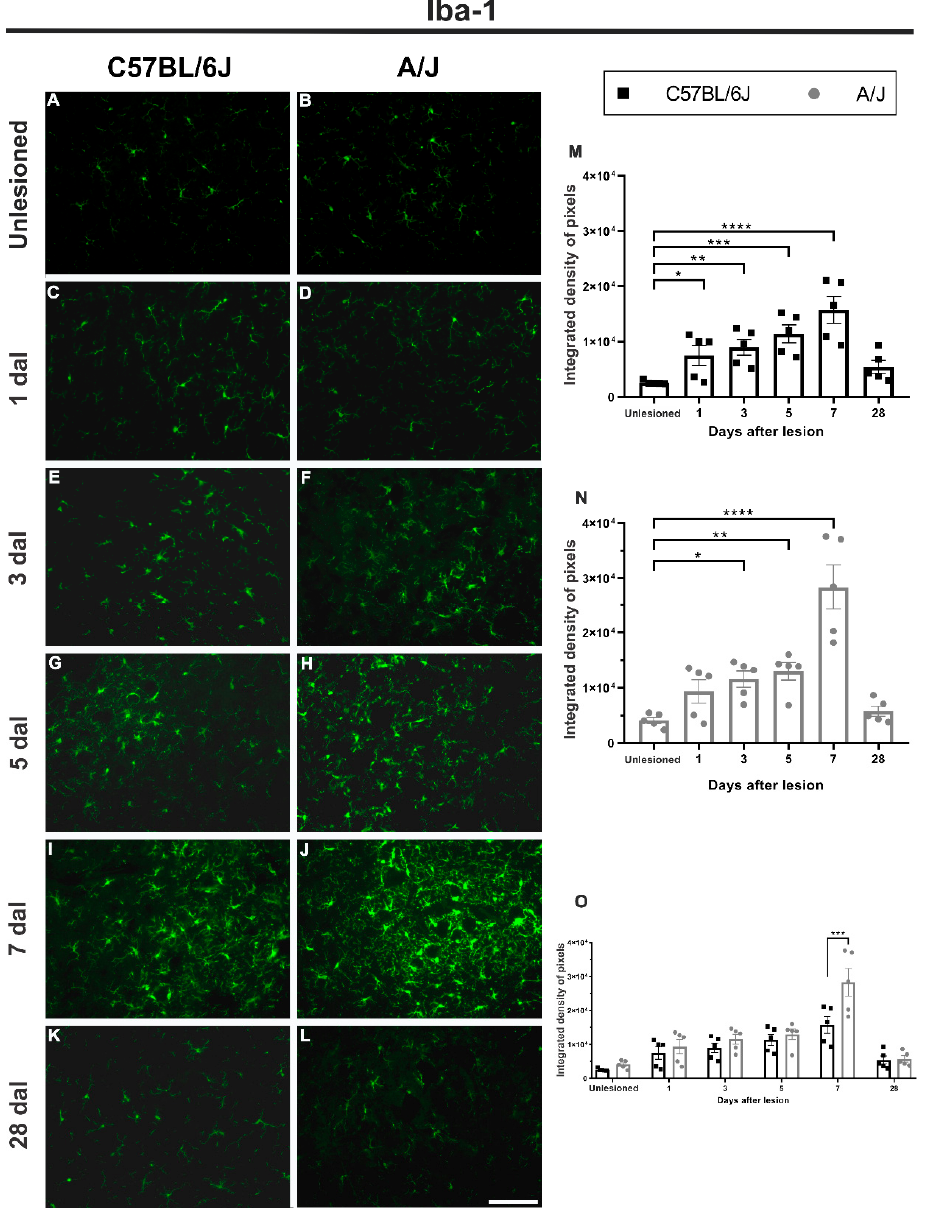
Figure 4. The microglial reaction (Iba-1 immunostaining) increased over time, with earlier upregu- lation in the C57BL/6J strain after sciatic nerve crush and with a peak at 7 days in both strains, being higher in the A/J strain. ( A – L ) Representative images of lamina IX of Rexed from control animals and from groups that received peripheral nerve crush on Days 1, 3, 5, 7, and 28, ipsilateral to the lesion (except the control), in both strains. ( M ) Microgliosis in C57BL/6J animals, with a progressive increase in Iba-1 staining from 1 to 7 dal. At 28 dal, the microglial reaction decreased, equaling the value found in the control group. ( N ) Reactive microgliosis in A/J animals, with a progressive in- crease in Iba-1 staining from 3 to 7 dal, within the studied intervals, the latter being the highest value found; at 28 dal, microgliosis decreased, equaling the value found in the control group. ( O ) Com- parison between the values found in the C57BL/6J and A/J strains throughout the time course after peripheral nerve injury, with a significant difference between the strains on Day 7. Quantification of the integrated density of pixels within lamina IX of Rexed (n= 5 per group/day for each strain). Mean ± SEM; * p < 0.05; ** p < 0.01; *** p < 0.001; **** p < 0.0001. Scale bar: 100 µm.